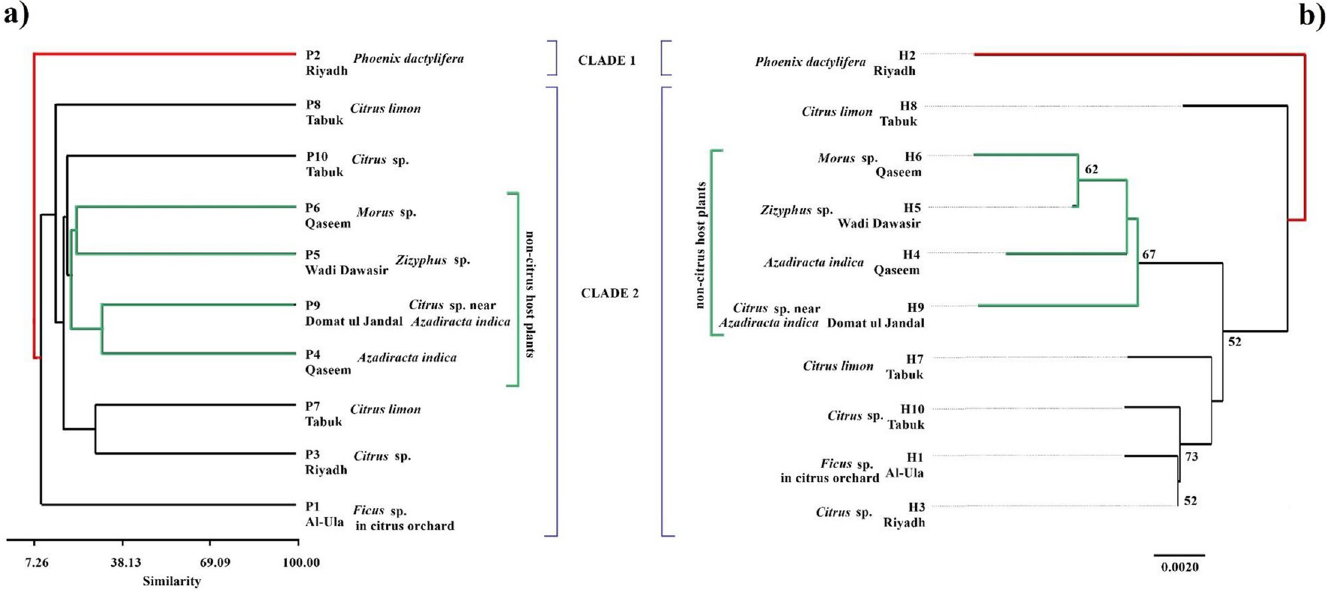
Fig 2. a) UPGMA phylogenetic tree based on different morphological characters of 10 E . orientalis phenotypes (P1-10) recovered from different hosts and regions b) NJ phylogenetic tree based on ITS2 sequences of E . orientalis from Saudi Arabia. Bootstrap values on the branches of the tree were generated with 1000 replicates.